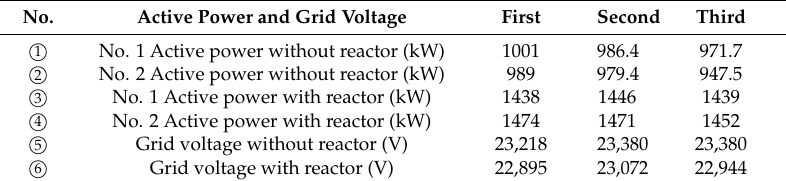
12 of 16 Figure 11. Two-reactor operations ( a ) first ( b ) second ( c ) third ( d ) fourth. Secondly, the daily connection voltage data before and after installing the reactor are analyzed. To compare the test results before and after installing the reactor, tests are conducted on the daily-maximum generation day in the same season to provide the same condition. The excessive voltage rise occurs when the generator output is connected to the grid without a reactor so that the output-rise can be 1000 kW, which is two-thirds of the rated output. Table 5 and (a), (b) and (c) of Figure 12 present the comparison data of the output active power and the daily grid voltage before and after installing the reactor. The voltage of the connection point increases with increasing the output of REGs. On the other hand, despite the increase in output, the voltage decreased due to the reactor operation. (a), (b) and (c) of Figure 12 show that the generator outputs are increased by 455